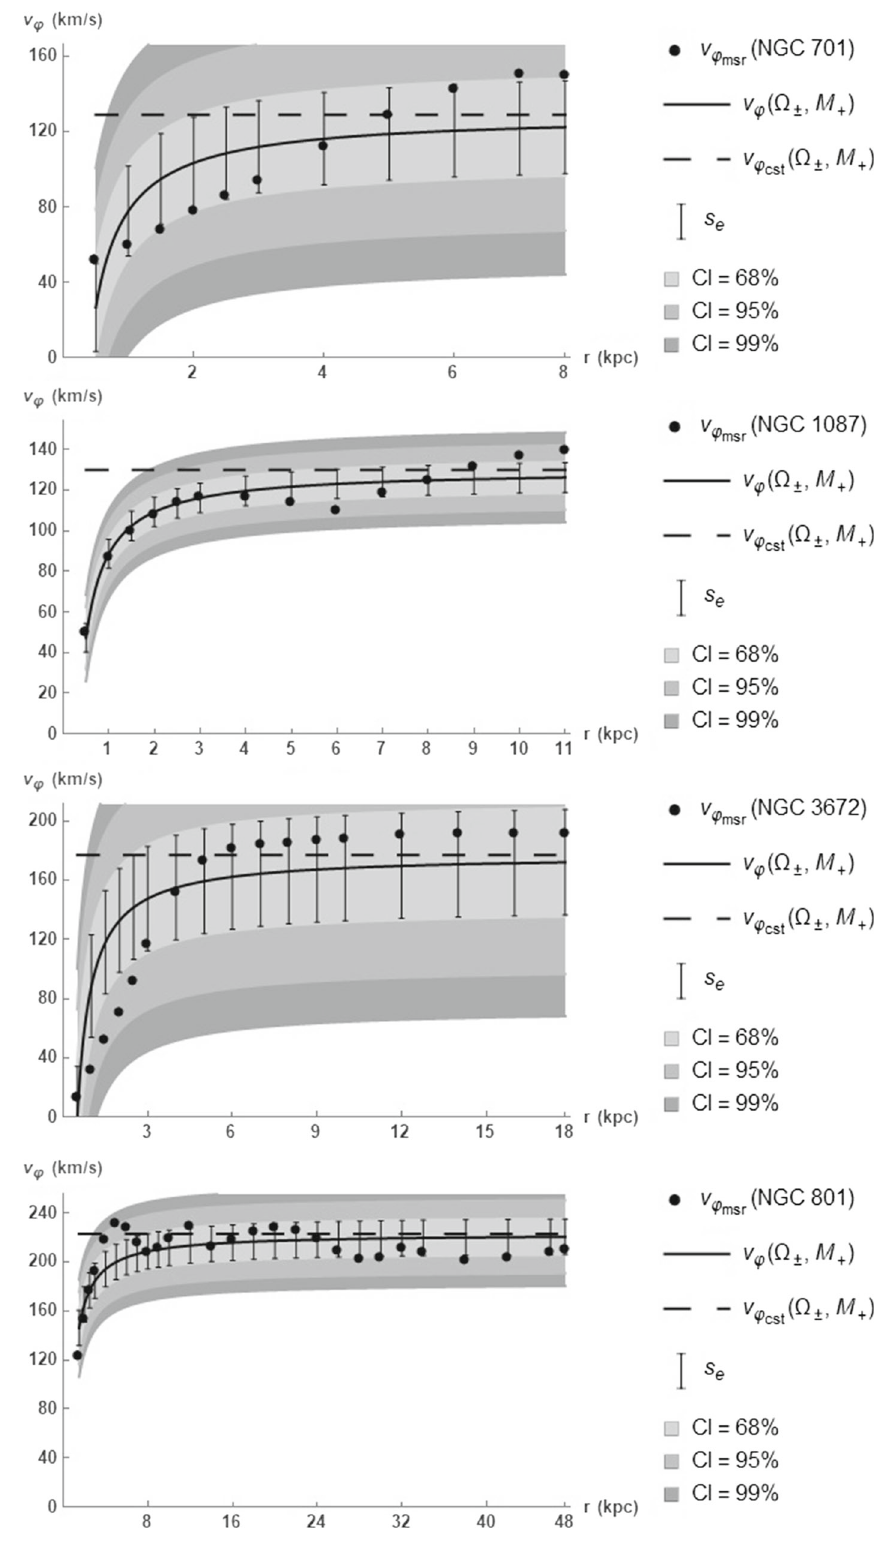
Fig. 3 Stars velocities of the NGC 701, NGC 1087, NGC 3672 and NGC 801 galaxies [10] compared to the best fit of the function (48). When (cid:13) = (cid:13) + , the curves show the fits for when the C 4 and C 5 constants are real and there is CTC in the range represented in the graph, because g ϕϕ < 0; when (cid:13) = (cid:13) − , C 4 and C 5 are imaginary, g ϕϕ > 0, and there is no CTC, and the metric is Euclidean, because g tt > 0. The values of the constants and the coefficient of determination for each galaxy are in the Table 1, and the values of the measured and calculated velocities, the standard errors and the CIs are in Tables 3–6 of the